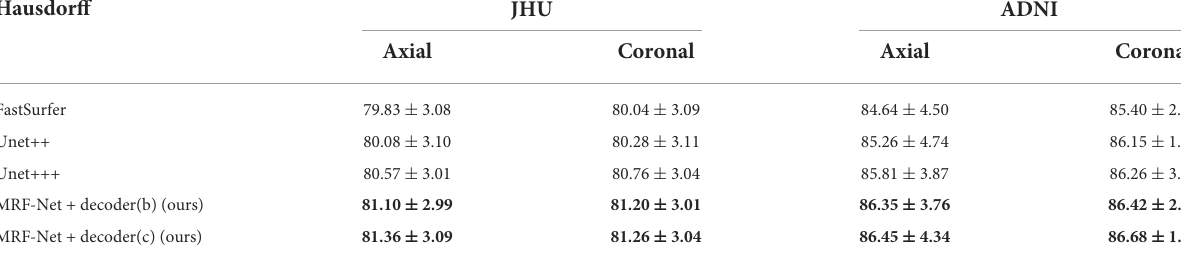
TABLE 3 Average dice score across the axial and coronal segmentation results.